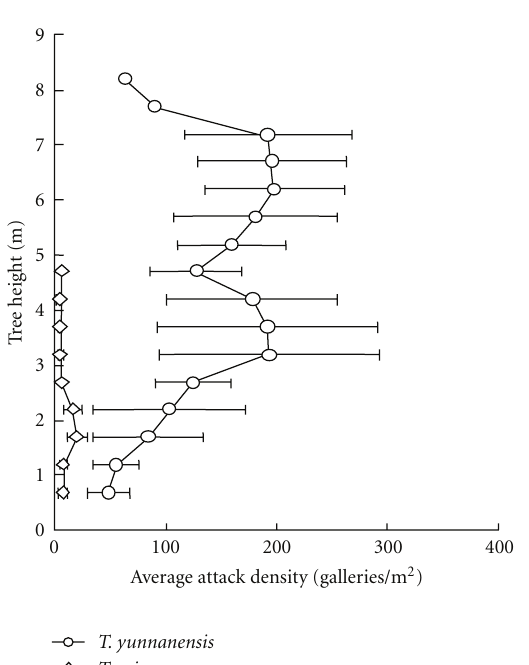
Figure 1: Average attack (egg gallery) density ( ± SE) and distribu- tion of T. yunnanensis and T. minor along the trunks of Yunnan pines in November, 2005 (Qujing, Yunnan province, China).